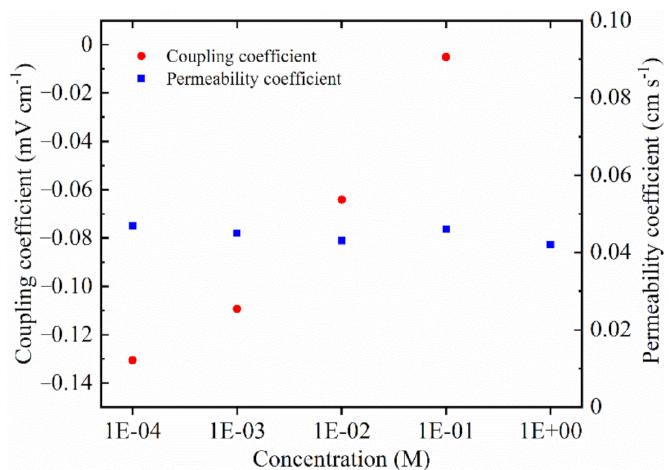
Figure 7. The relationship between the coupling coefficient and permeability coefficient of SRM at different concentration. The streaming potential coupling coefficient is equal to the slope of the linear